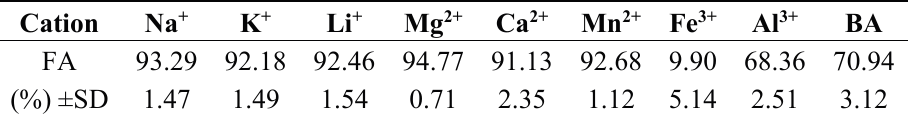
Table 1. Effect of cations on the flocculating activity of purified MBF-UFH